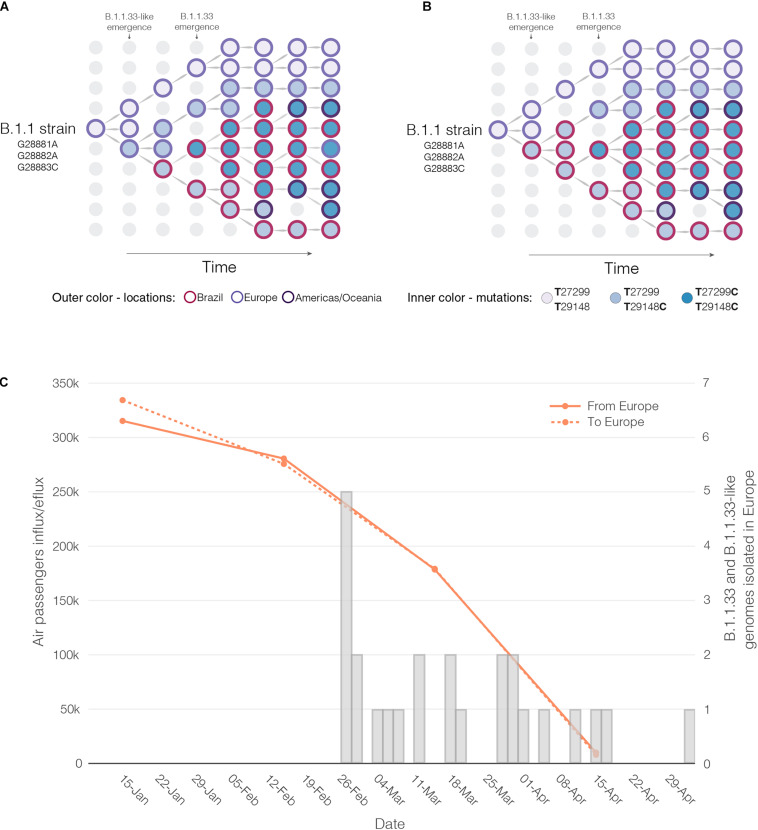
Putative origin and transmission history of the SARS-CoV-2 clades B.1.1.33-like and B.1.1.33. (A) Diagrams showing two alternative scenarios for the origin and dissemination of clades B.1.1.33-like and B.1.1.33. The left panel depicts the hypothetical scenario where a B.1.1.33-like strain carrying the mutation T29148C was introduced into Brazil from Europe (marked with an asterisk) and after a period of local transmission in Brazil arose the B.1.1.33 variant carrying the mutation T27299C, which dispersed all over the country and from Brazil to other countries in the Americas and Oceania. (B) This panel depicts the hypothetical scenario where a B.1.1 strain was introduced from Europe to Brazil, and mutations T29148C and T27299C arose at sequential steps during local transmission. According to this second scenario, Brazil was the epicenter of dissemination of both clades B.1.1.33-like and B.1.1.33 to other countries in Europe, the Americas, and Oceania. (C) Graphic showing the monthly number of international air passengers from South America, North America, and Europe that arrived in Brazil during 2020 (available at: https://www.anac.gov.br) (left-hand axis) along with probability density of TMRCA estimates for clades B.1.1.33.like (gray) and B.1.1.33 (red).